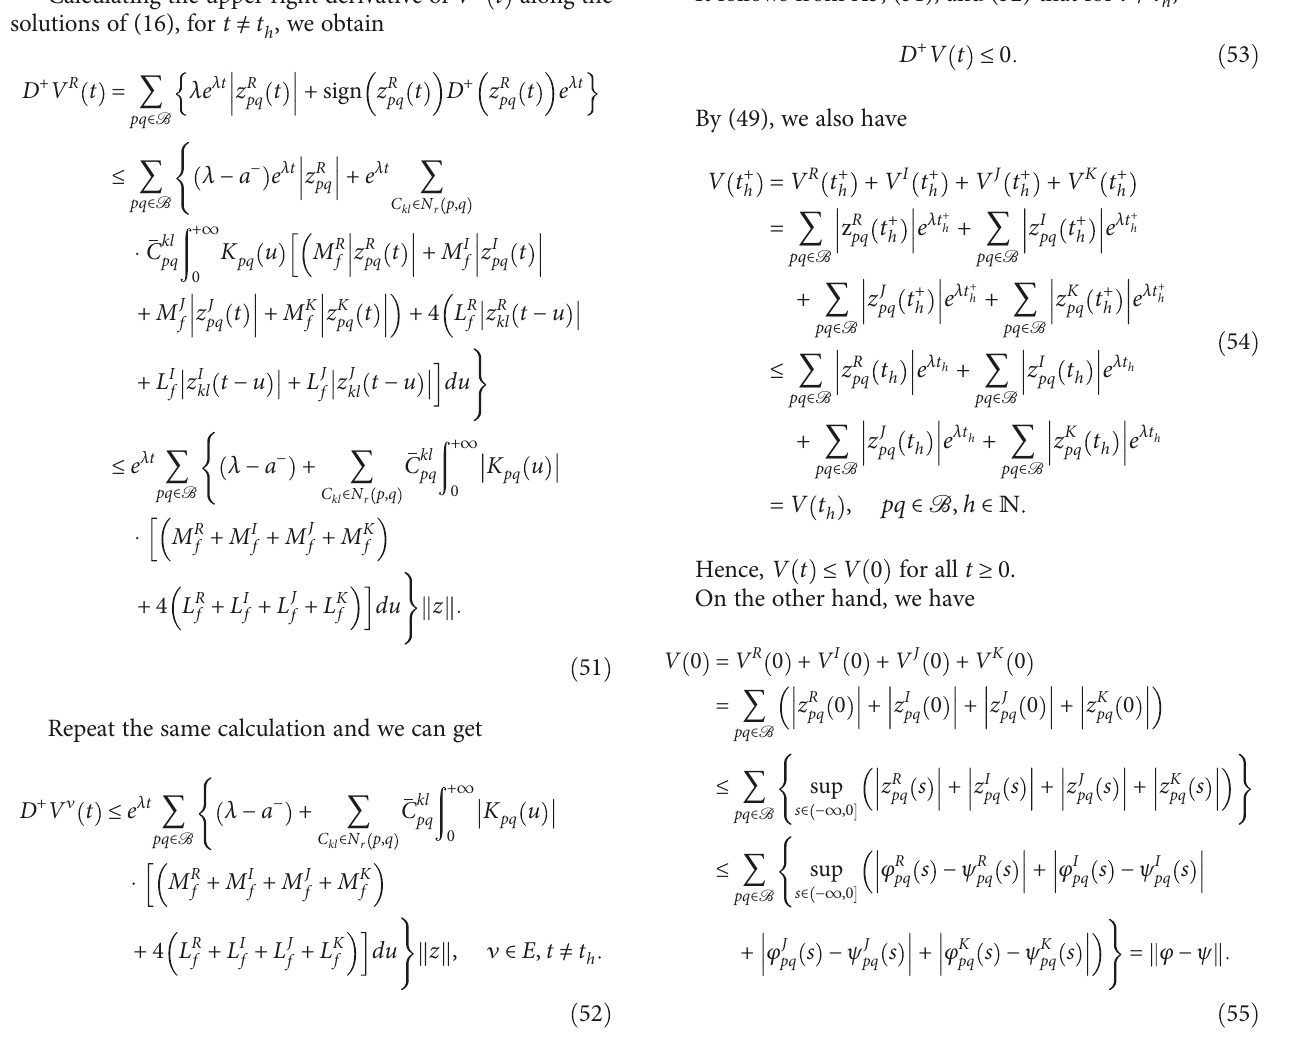
, x , x , and x 11 12 21 22